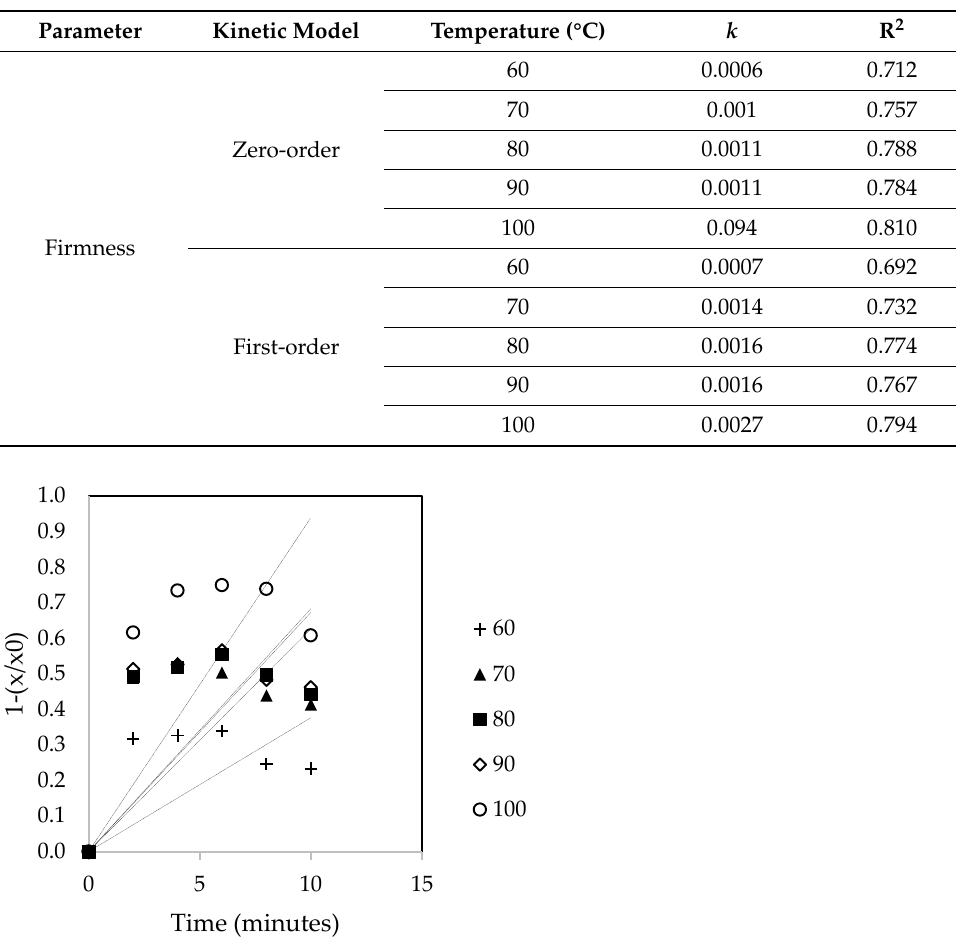
Figure 5. Zero-order kinetic model of the effect of blanching (60, 70, 80,90 and 100 °C) on the firmness of Dabai fruit